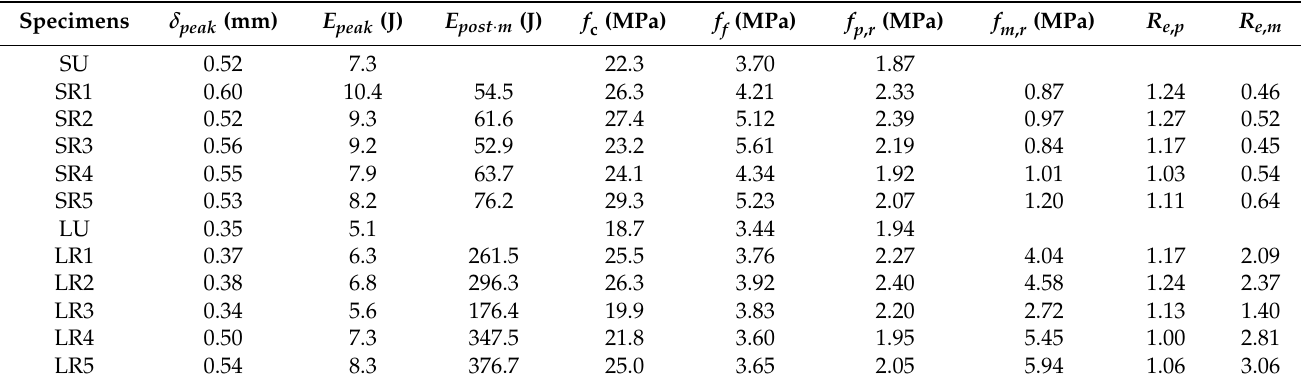
Table 4. Energy absorption and toughness index.